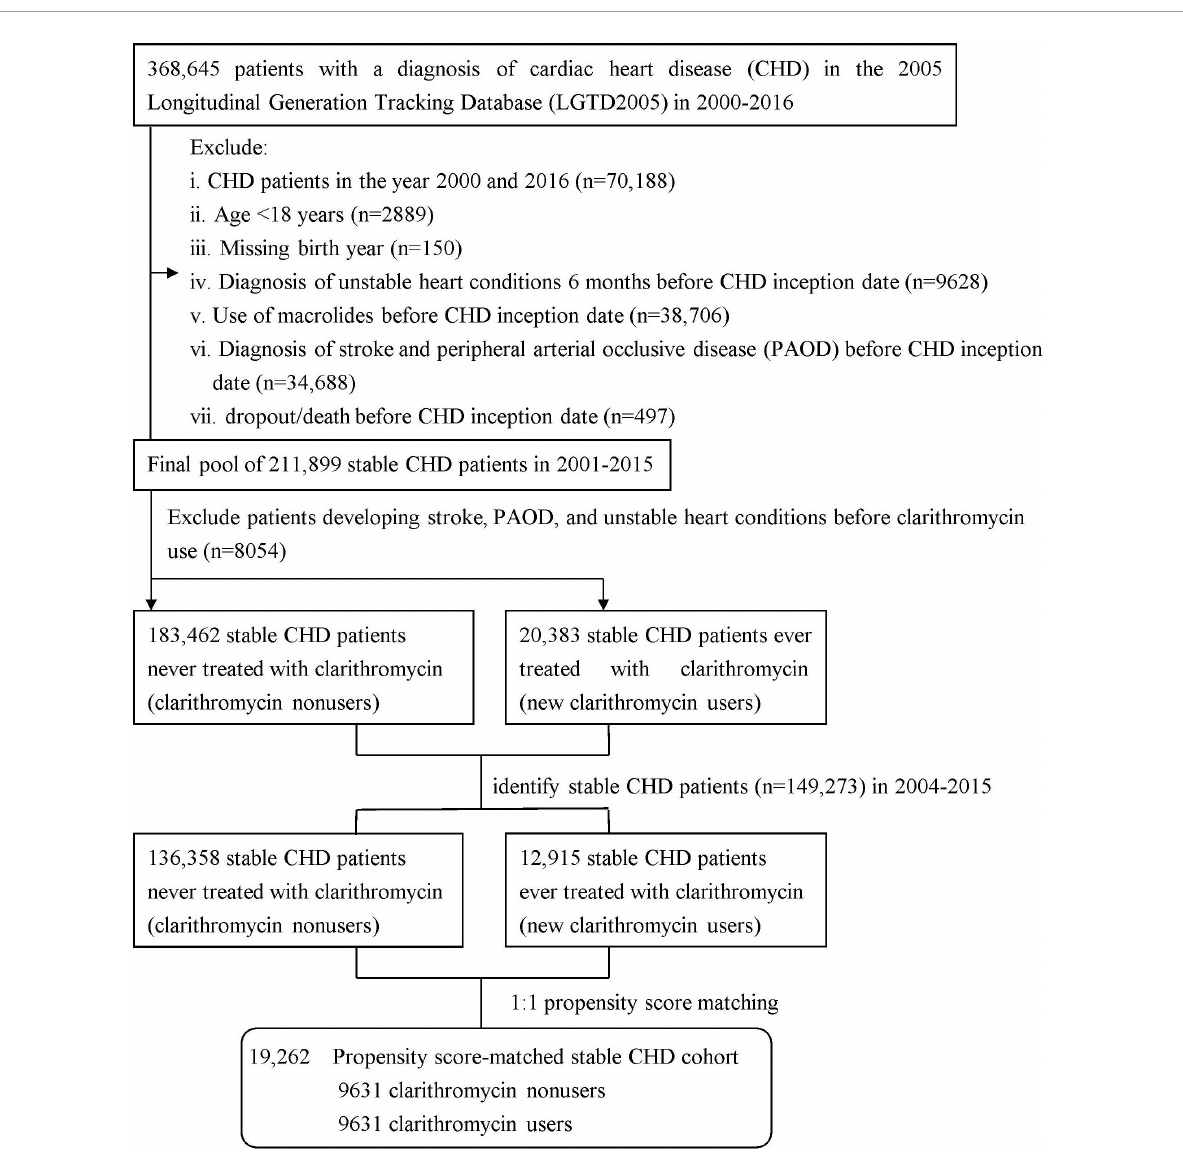
FIGURE1 Flowchart of study